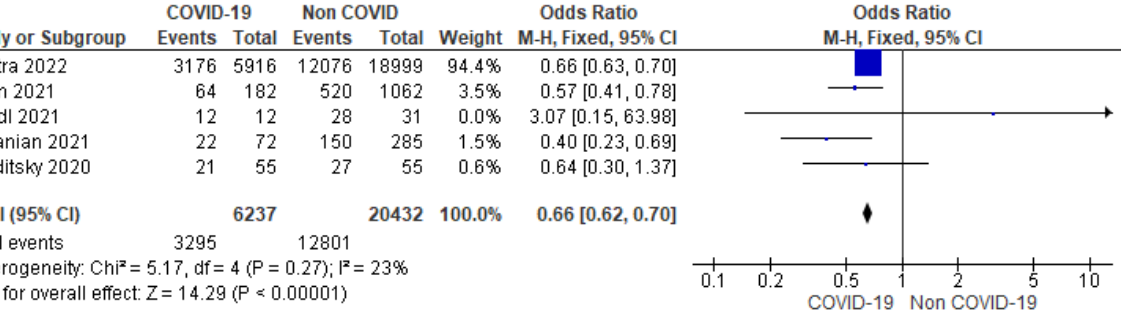
Figure 4. Forest plot showing group di ff erences on TTM use among COVID-19 versus non-COVID- 19 patients using fi xed e ff ect model. [13–15,17]. F. Coronary angiography Three studies reported the results of coronary angiography performed after cardiac arrest. Proportions of 3.24% (10/309) of COVID-19 patients and 9.7% (136/1402) of non- COVID-19 patients underwent coronary angiography following cardiac arrest with sig- ni fi cantly lower odds of coronary angiography among COVID-19 patients (OR = 0.34; 95% CI = 0.17 to 0.65; n = 1711; I 2 = 0%) (Figure 5).